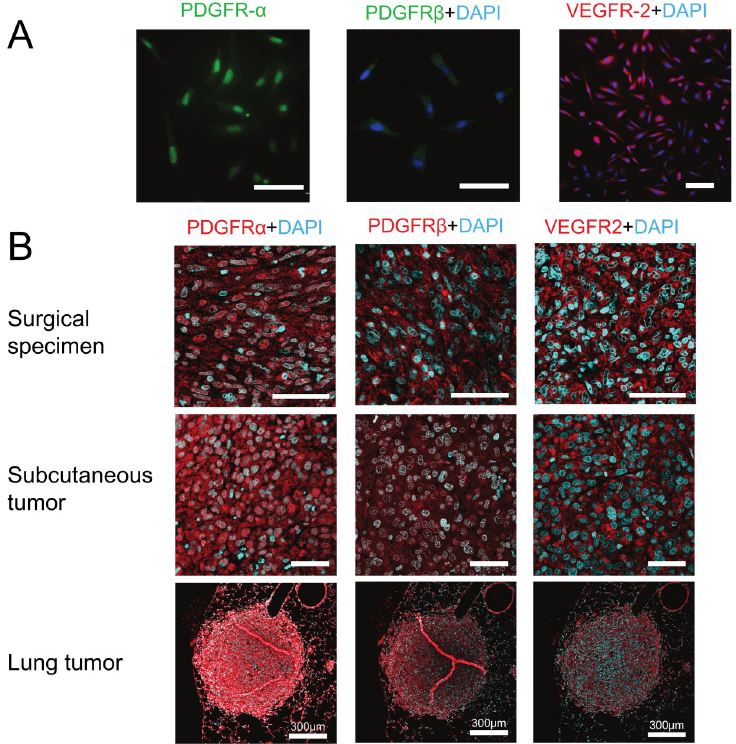
Fig 6. Immunocytochemistry and immunohistochemistry for tyrosine kinase receptors in PIS-1 cells. (A) Immunocytochemistry shows that PIS-1 cells were positive for platelet-derived growth factor receptor (PDGFR)- α , PDGFR- β , and vascular endothelial growth factor receptor (VEGFR)-2. (B) Immunohistochemistry shows that the tumor components of the surgical specimen, and subcutaneous and pulmonary tumors formed from PIS-1 cells and were diffusely positive for PDGFR- α , PDGFR- β , and VEGFR-2. All scale bars, 50 μ m unless otherwise